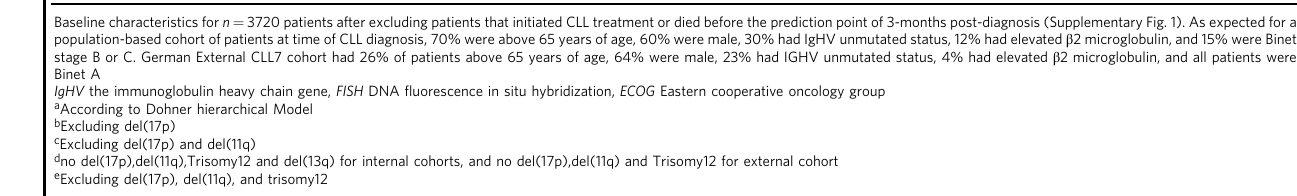
Supplementary Table 4). CLL-IPI score ranks a patient ’ s risk